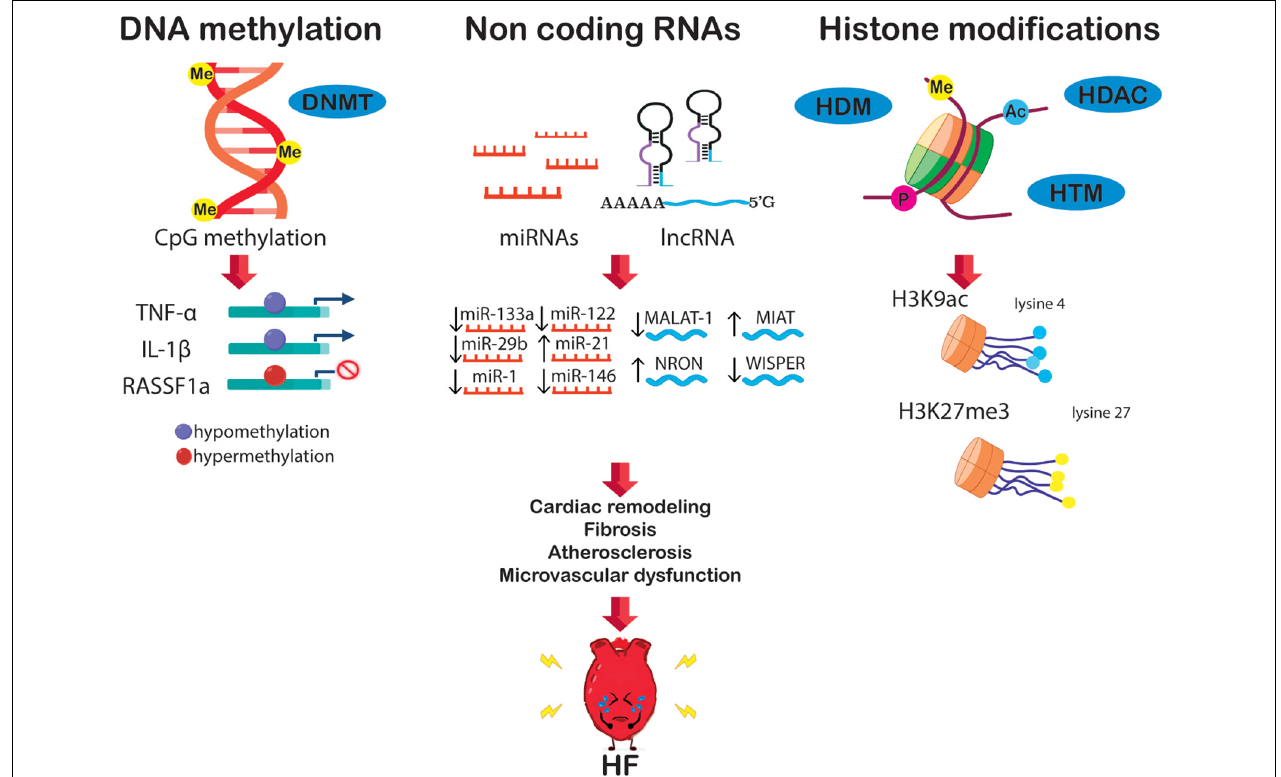
FIGURE 2 | The epigenetic network in HF is potentially orchestrated by alterations of DNA methylation, non-coding RNA, and histone modification. These alterations boost transcriptional changes leading to crucial HF features, i.e., diabetes, fibrosis, cardiac remodeling, atherosclerosis, and microvascular